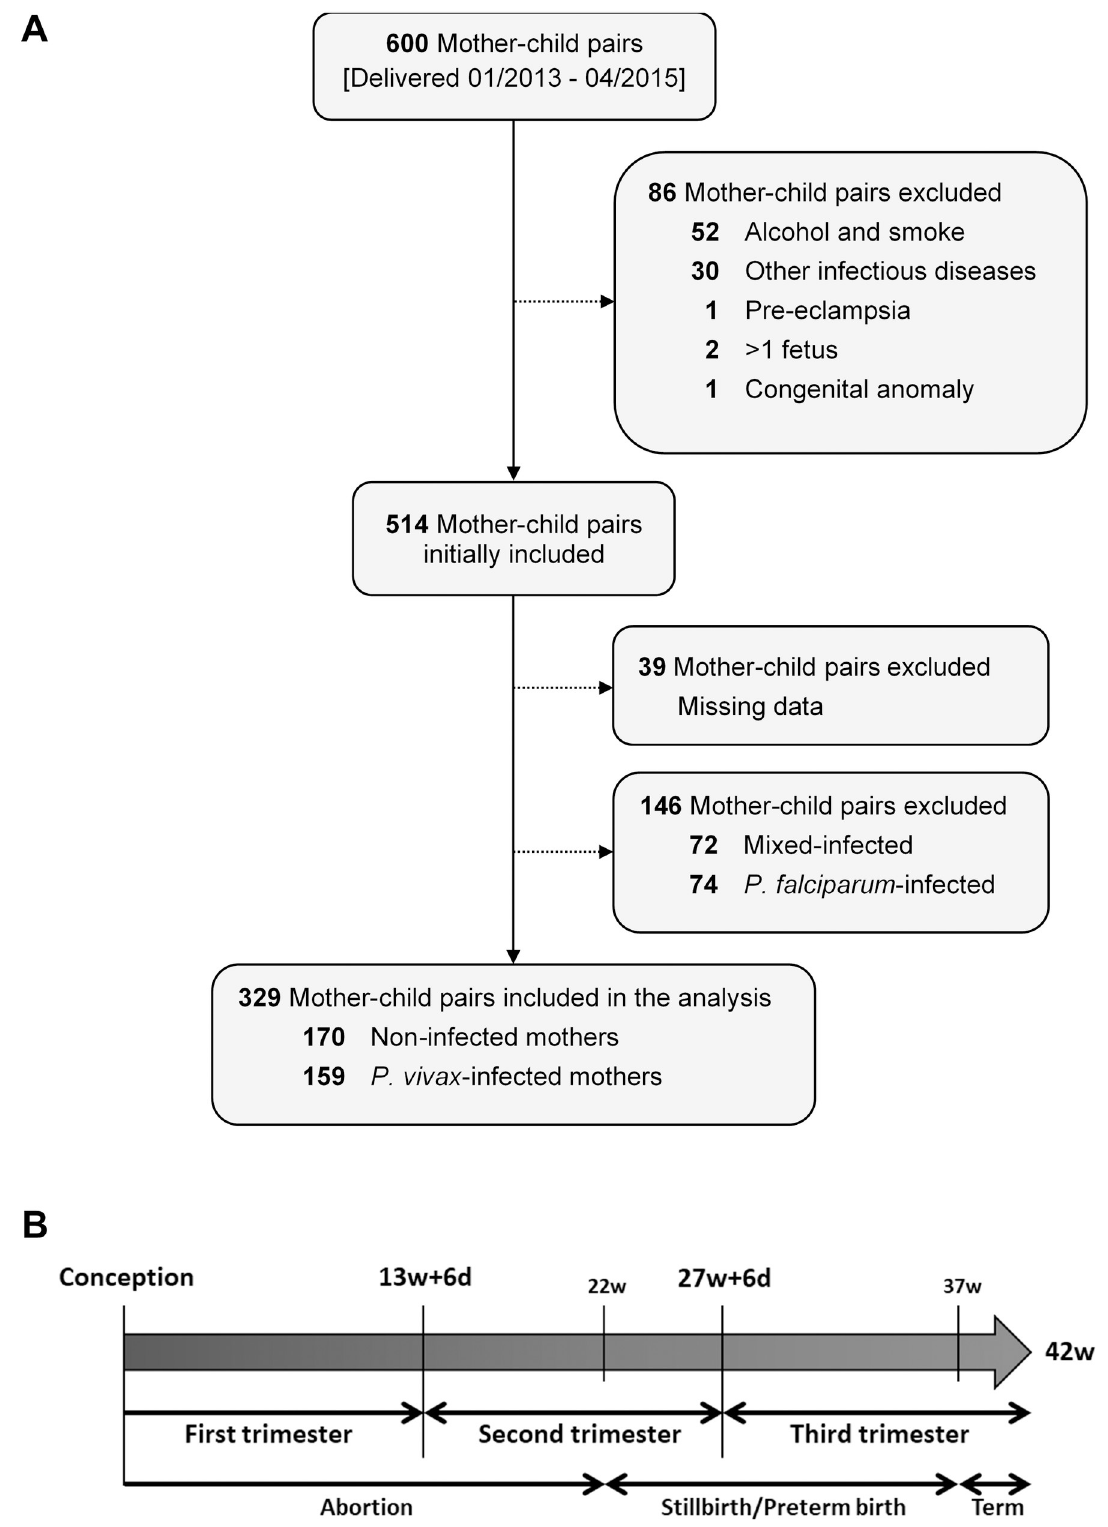
Fig 1. Description of study participants and definitions. (A) Flow chart detailing exclusion criteria applied prior data analysis; (B) Definitions of pregnancy partitions used in the report. Mixed infection– P . vivax and P . falciparum infections occurring at the same or different times during pregnancy; w—weeks;